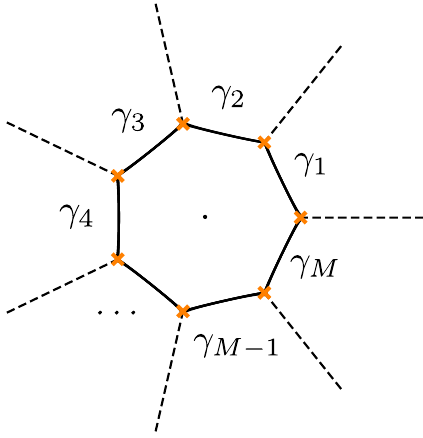
Figure 19. BPS graph of the ( A 1 ; D 7 ) Argyres-Douglas theory.